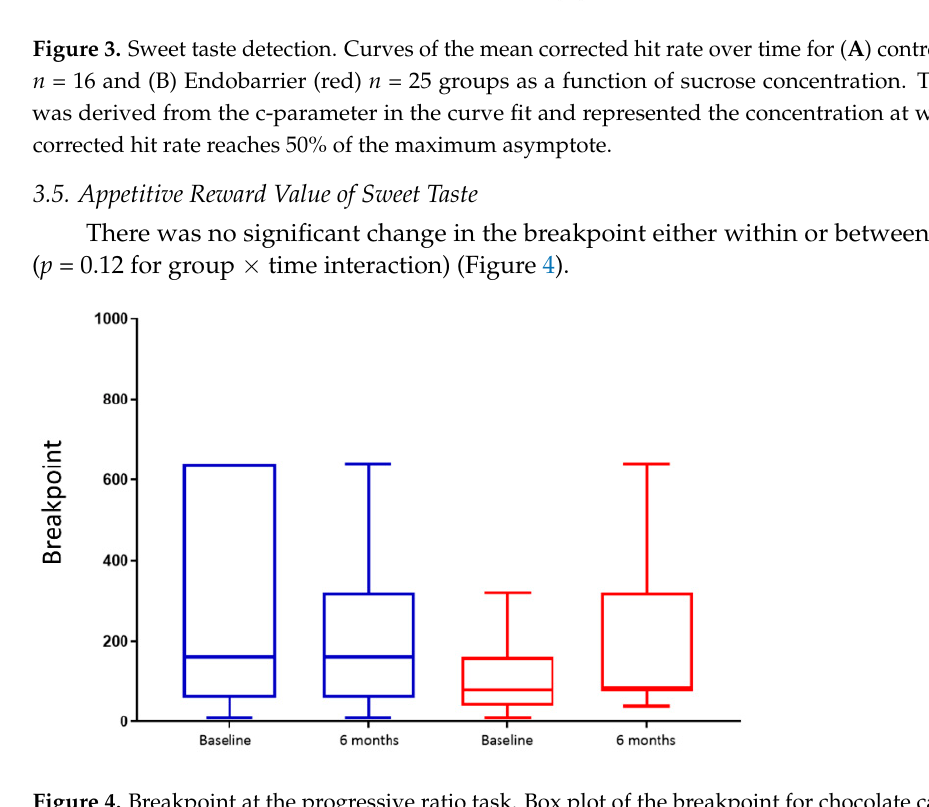
Figure 4. Breakpoint at the progressive ratio task. Box plot of the breakpoint for chocolate candies in control (blue) n = 9 and Endobarrier (red) n = 11 groups. The lower and upper boundaries of the box represent 25th and 75th percentiles, respectively. Lower and upper whiskers represent 10th and 90th percentiles, respectively. The line in the middle of the box represents the